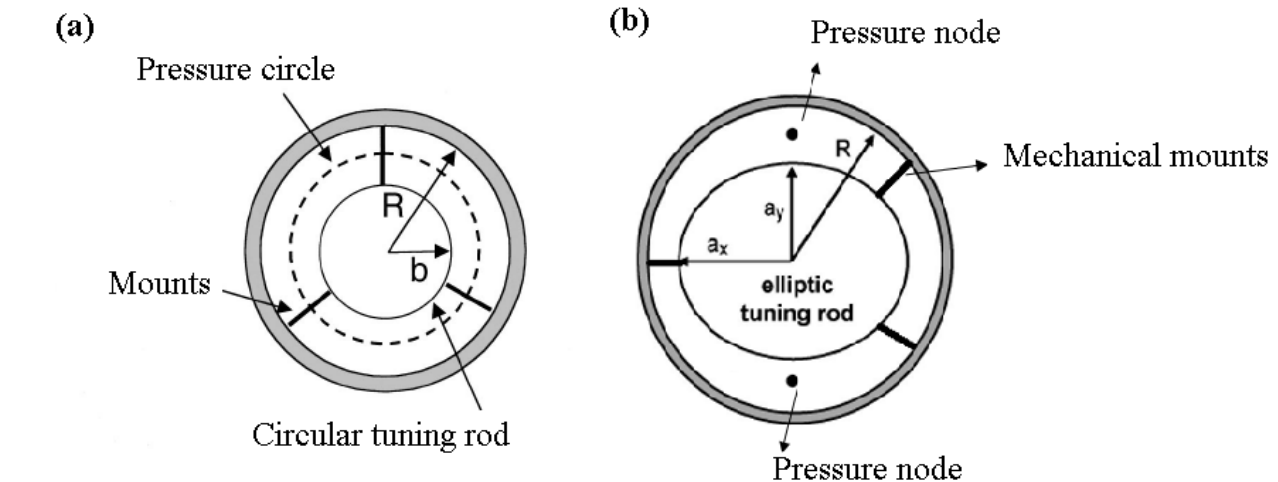
Figure 4. Cavity tuning in a piezoelectric transducer by inserting a circular ( a ) and elliptical ( b ) tuning rod inside the transducer [44,45].